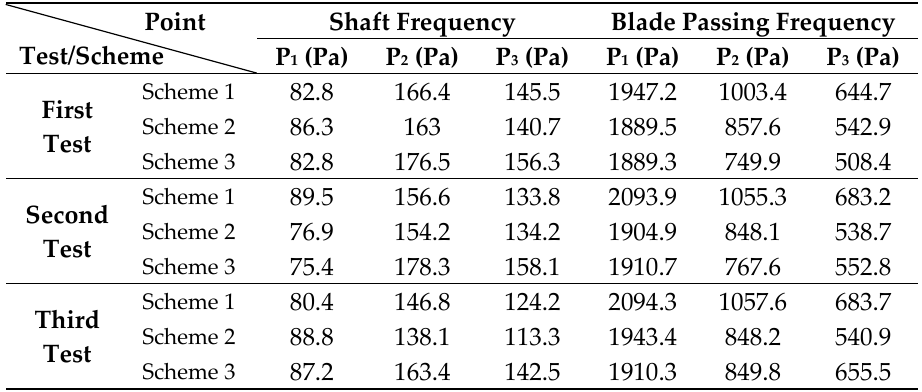
Table 1. Three sets of experimental